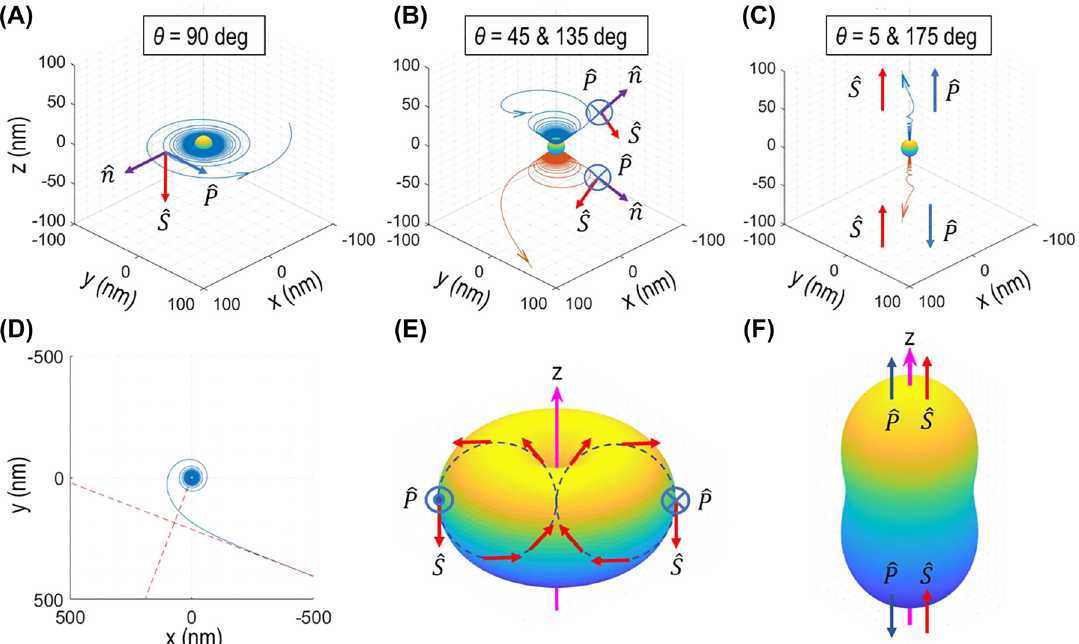
Figure 3: Energy flow lines and Poynting vector distributions. Trajectories calculated for three different polar angles: (A) 𝜃 = 90 ◦ ; (B) 𝜃 = 45 or 135 ◦ ; and (C) 𝜃 = 5 or 175 ◦ . (A–C) Plotted for r of 10–100 nm. The inner-most part of a trajectory (shown with a sphere: r < 10 nm) is excluded in this plot in order to reduce computational load: the flow lines make a large number of windings at near field (e.g., ∼ 10 7 for r of 5–10 nm). The densely spaced vortex profiles are not clearly resolved in these plots. Spins orient orthogonal to energy flow direction (transverse spins) at near field. The three ̂ S = ̂ P × ̂ n . (D) An energy flow trajectory plotted on an equatorial unit-vectors (spin, energy flow, and evanescent direction) form a right-handed triad plane ( 𝜃 = 90 ◦ ): a flow line spirals out to far field asymptotically approaching a straight-line exit. The orbital angular momentum value ranges from 0 at kr = 0 to ℏ at kr = 1.03 (marked with a red circle) and 2 ℏ at kr = ∞ . Note that the asymptotic line at far field is displaced from a dipole by distance d = 𝜆 / π . (E and F) The angular ( 𝜃 , 𝜑 ) dependence of energy flow distributions calculated at near field ( kr << 1) (E) and at far field (F). The arrows denote spin angular momentum (red) and Poynting (blue) vectors at the locations where the likelihood of finding a photon is